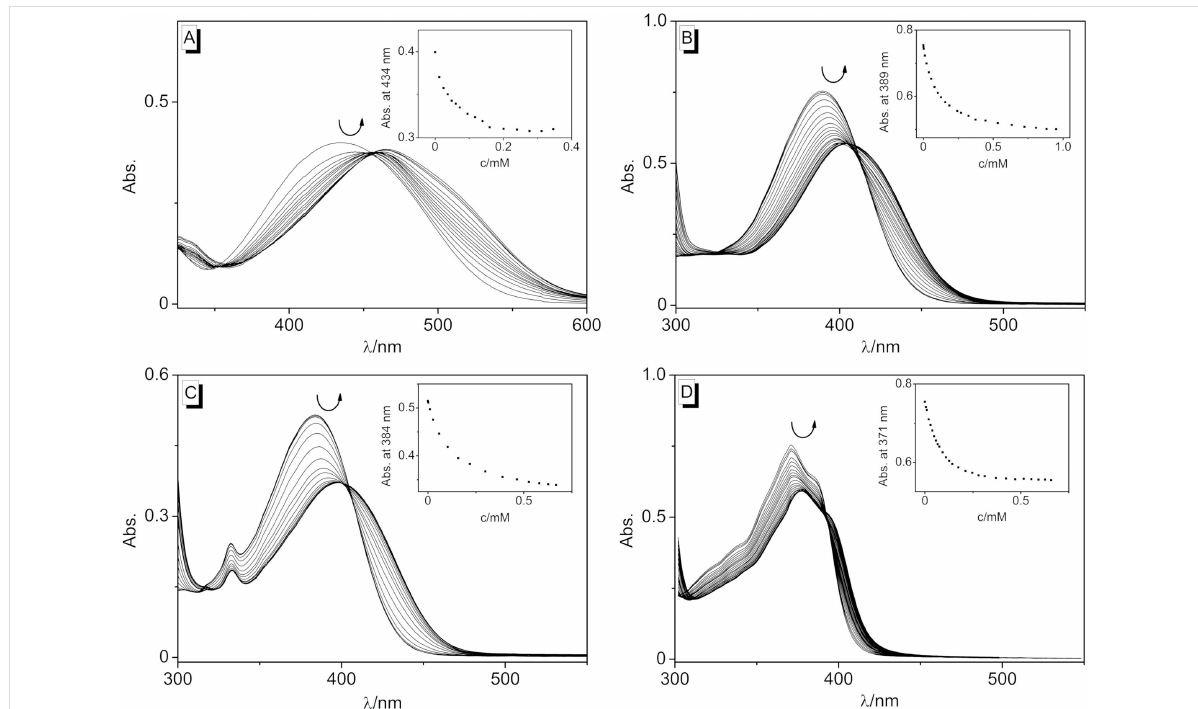
Figure 2: Spectrophotometric titration upon the addition of ct DNA to the styrylquinolizinium derivatives 3a (A), 3b (B), 3c (C), and 3d (D) in BPE [ c L = 20 µM, c DNA = 1.45 mM (A–C), c DNA = 2.45 mM (D), c DNA in base pairs]. The insets show the plots of absorption vs DNA concentration. The arrows indicate the changes of absorption upon the addition of ct DNA.